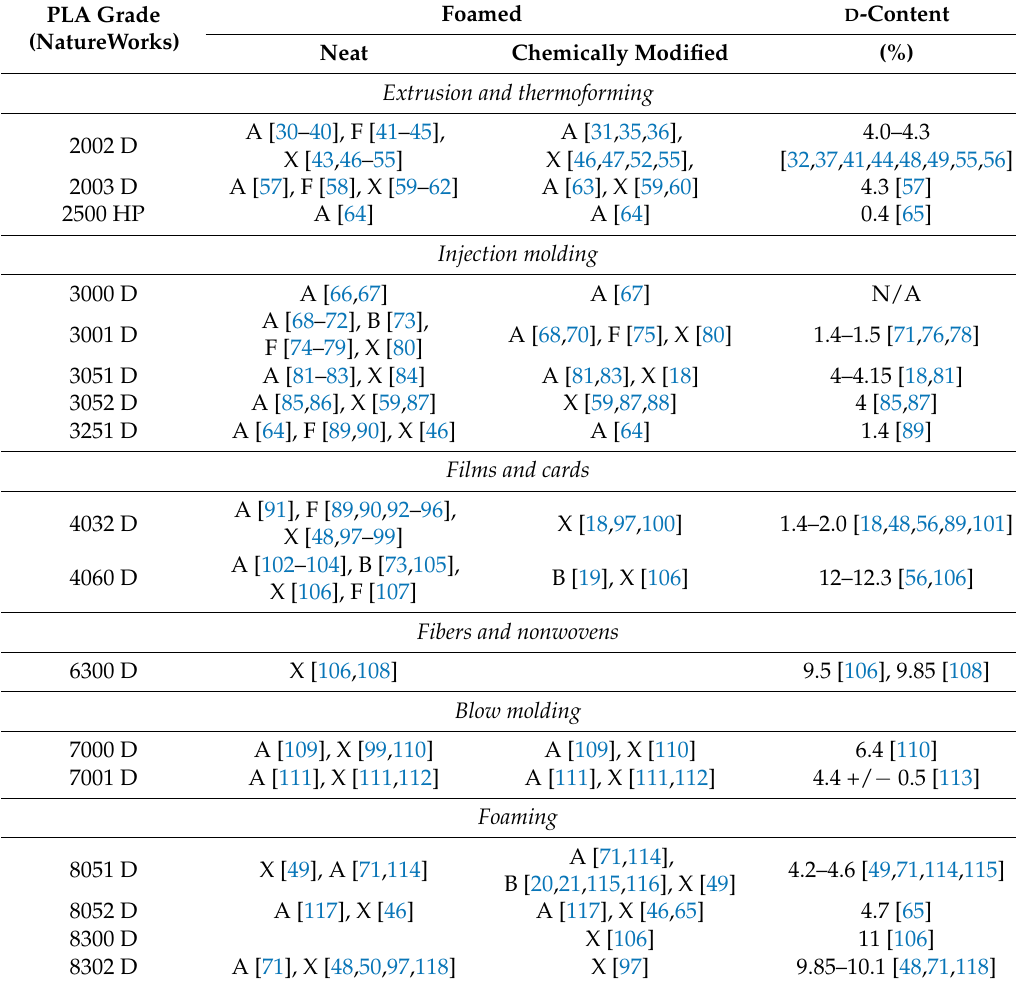
Table 1. Literature overview of polylactide (PLA) grades (NatureWorks LLC) used for foaming (blends with other polymers were not considered). Please note: the original purpose of the grade as recommended by the supplier can be found in italic letters above the grade